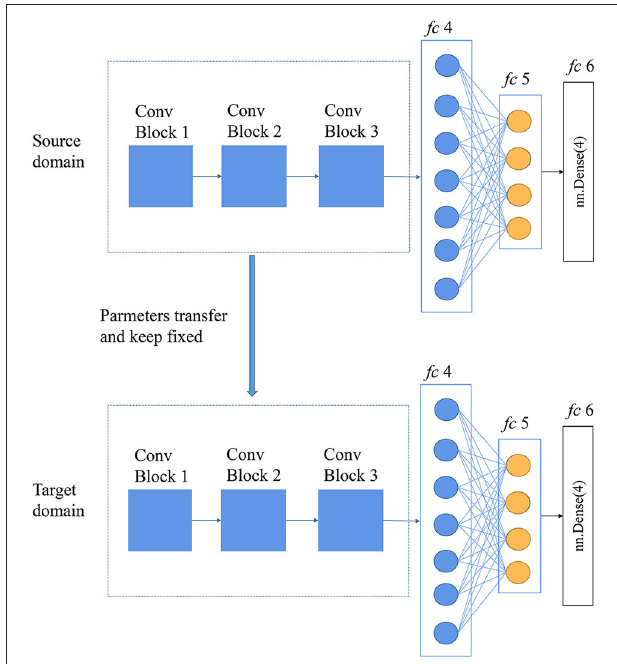
FIGURE 2 | Diagram of the fine-tuning